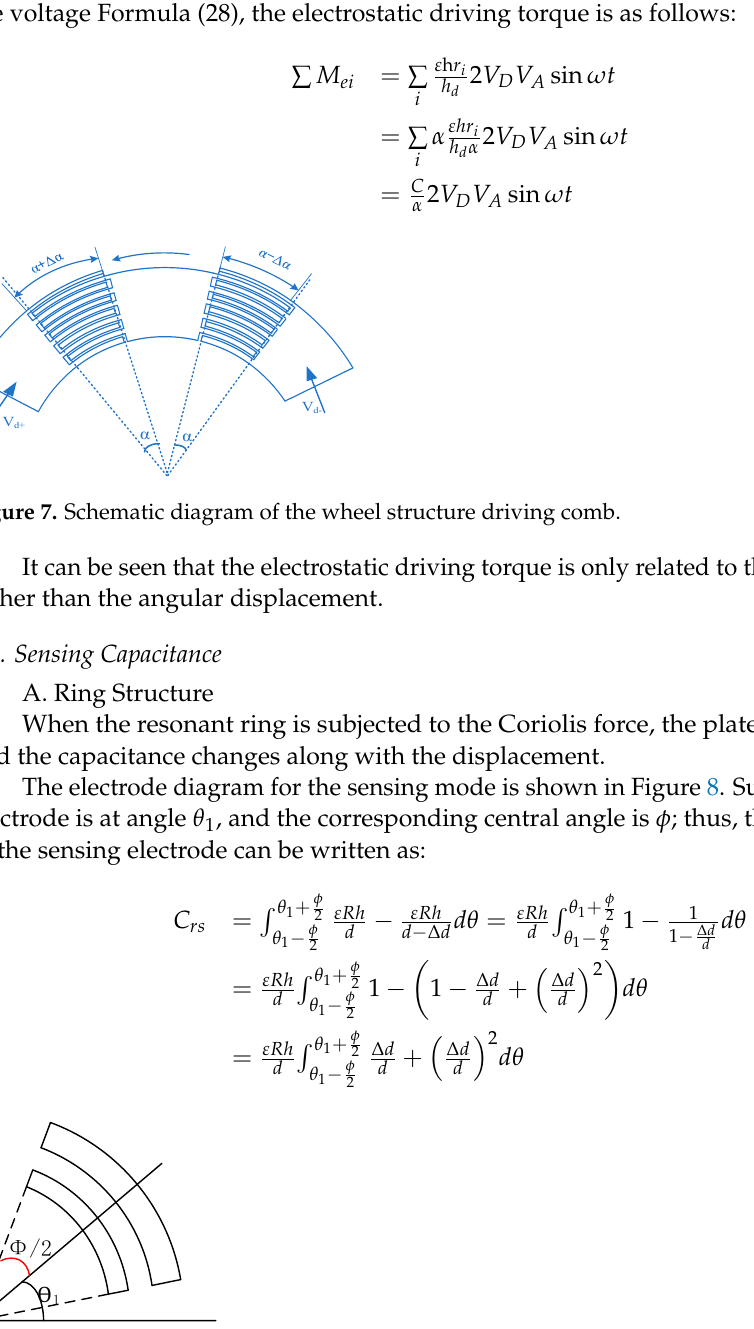
Figure 8. Position diagram of the resonant ring sensing electrode.